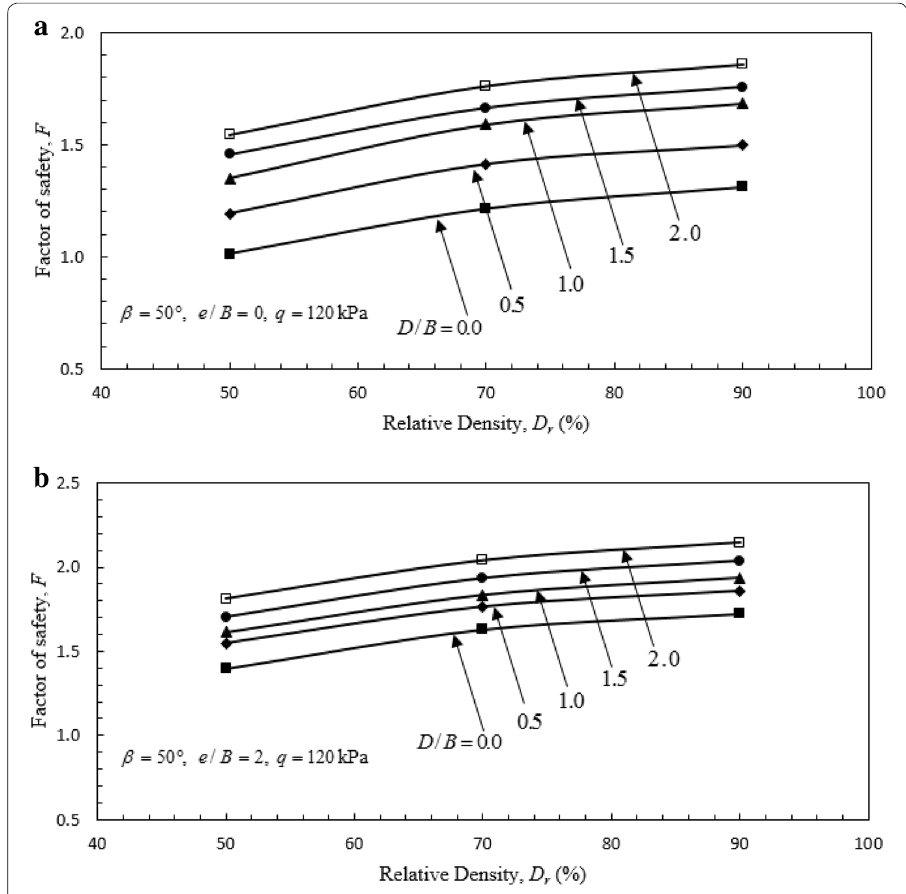
Fig. 10 Variation of factor of safety, F , with relative density, D r : a e / B = 0 , b e / B =